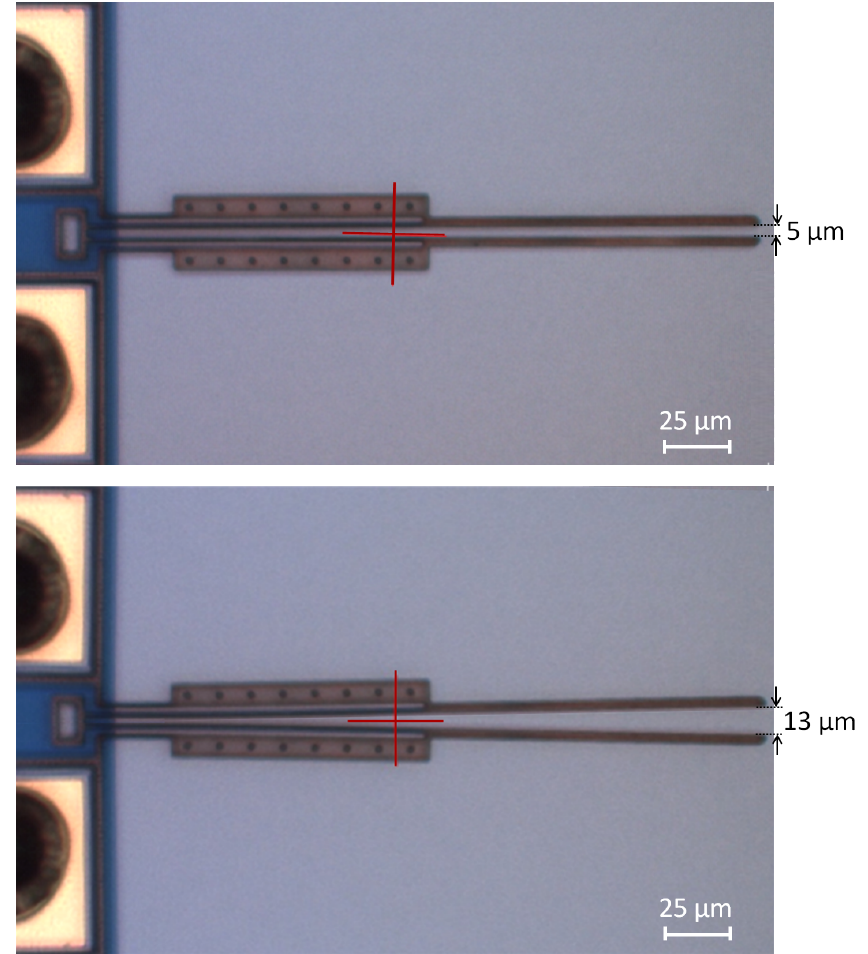
Figure 16. Images based on optical microscopy of one of the fabricated microgripper structures (Design 2) when not actuated ( top ), and when each arm is electrothermally actuated with 3 V ( bottom ). The pixel resolution of the vision system photographs is 1023 pixels (width) × 767 pixels (height), and the marked values give the absolute gap openings between the microgripper arm